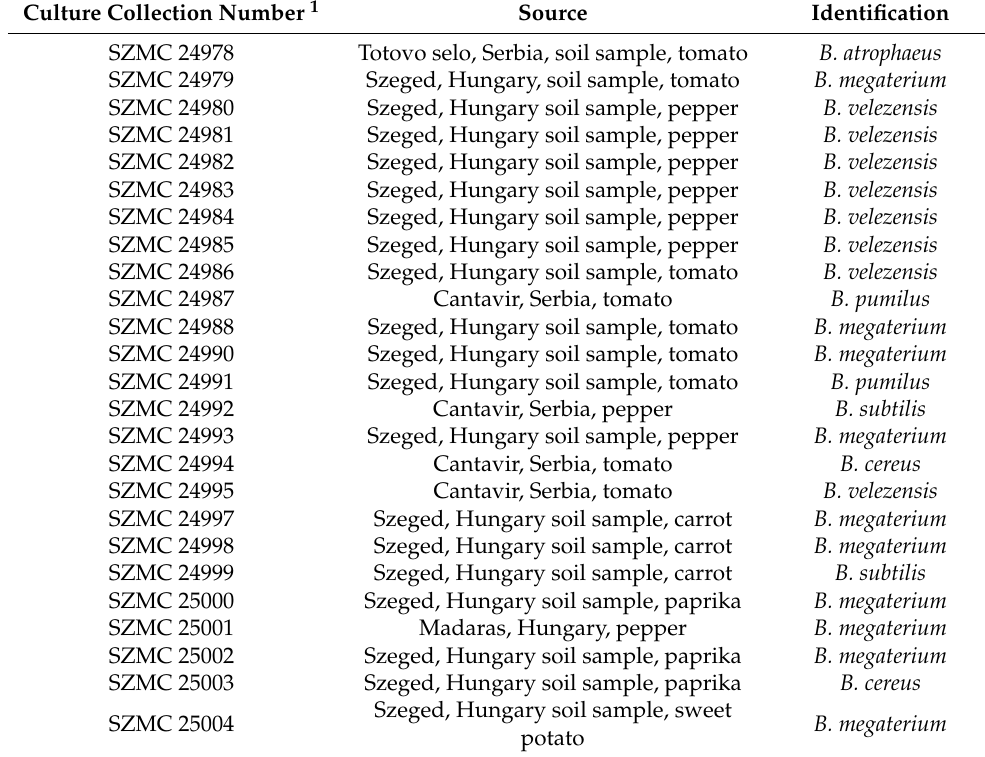
Table 1. List of the identified Bacillus isolates.